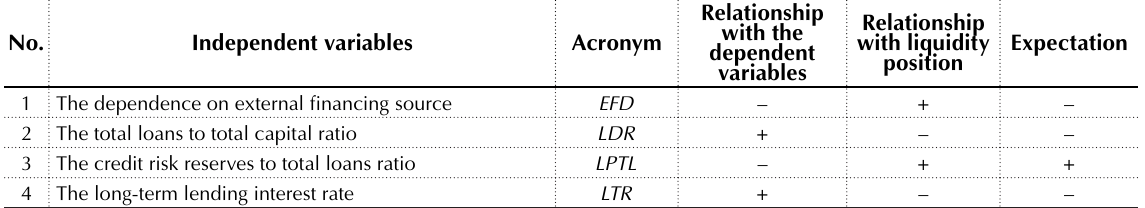
Table B4. Relationship between independent variables and dependent variables